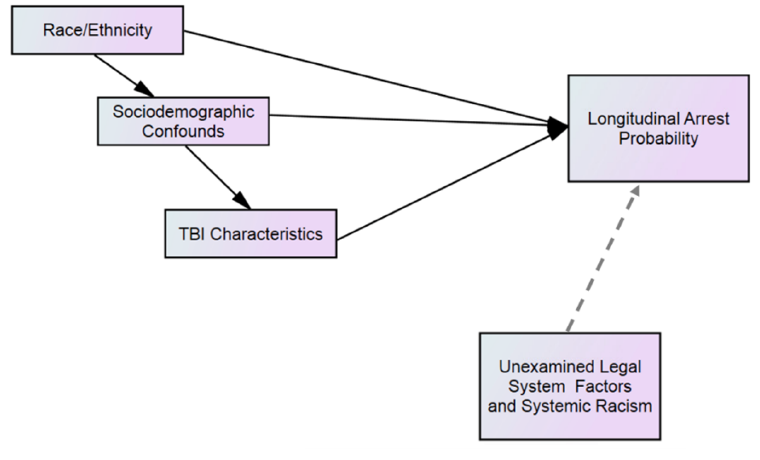
Figure 3. Proposed theoretical model.